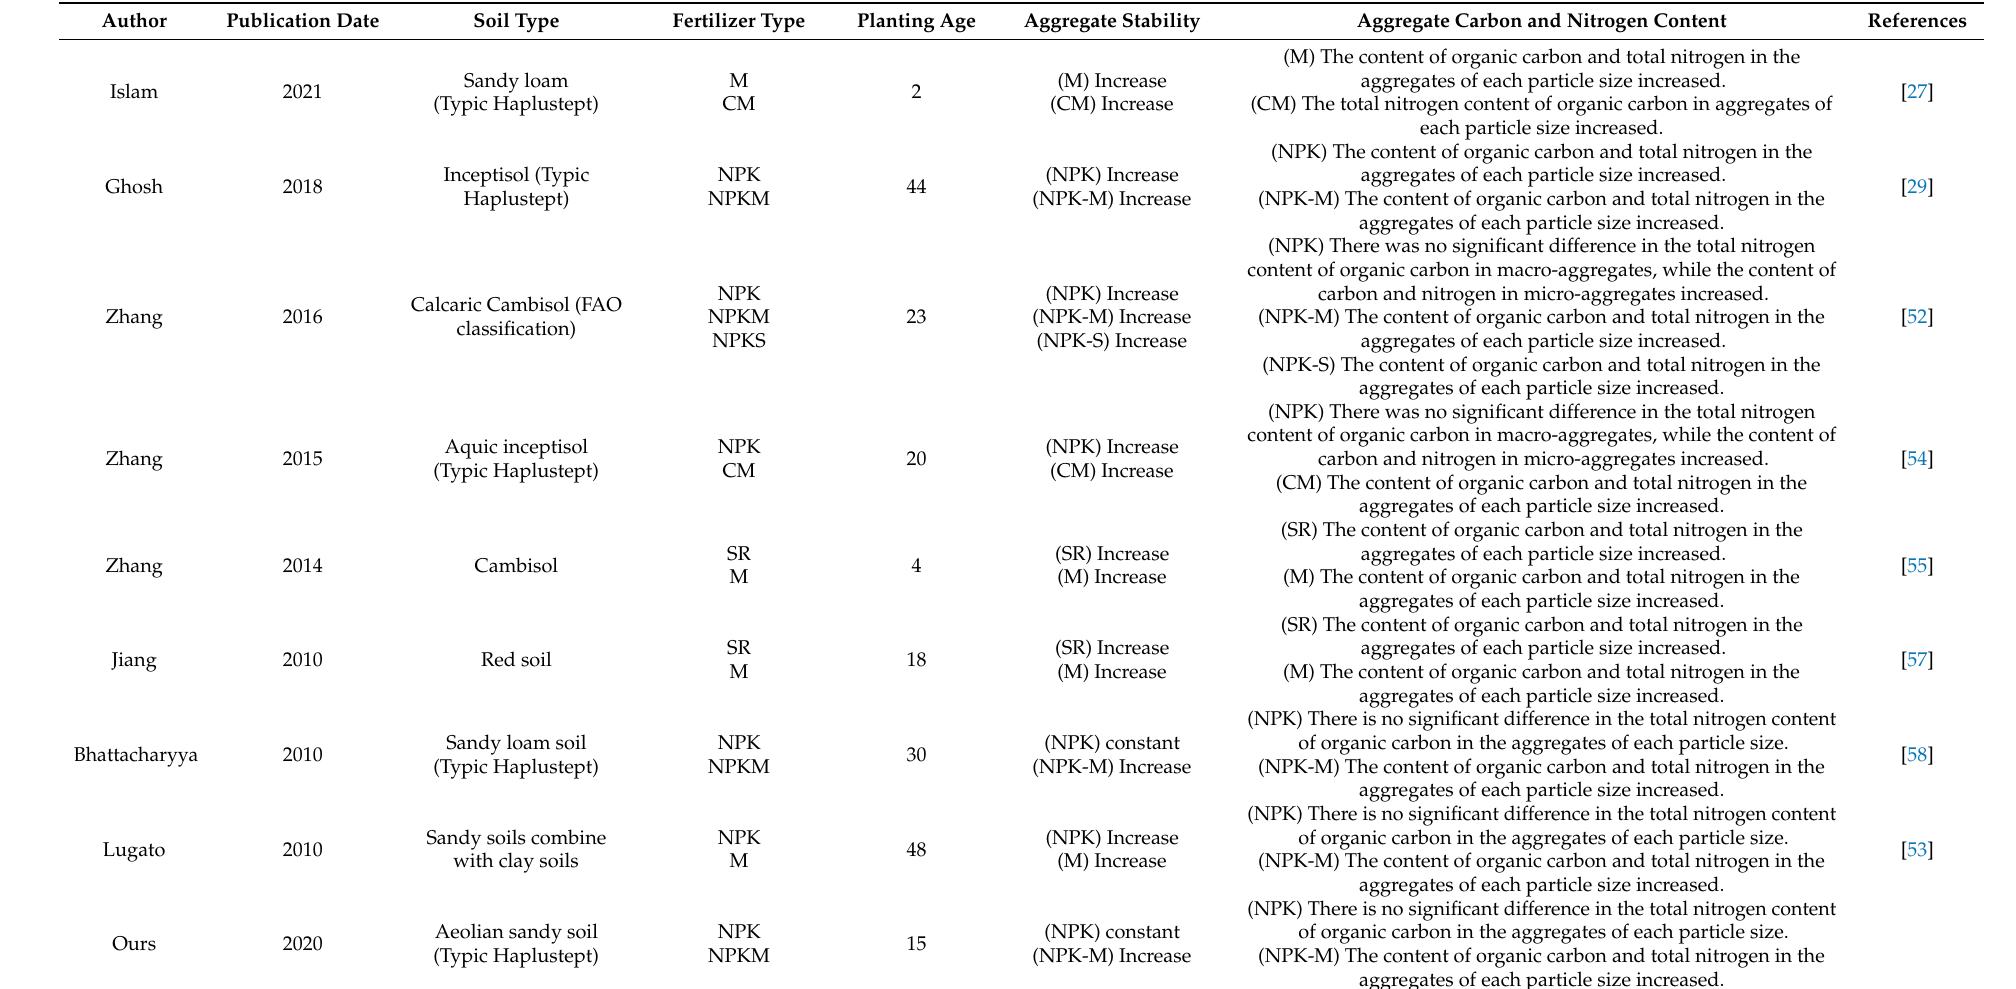
Table 5. Effects of long-term fertilization on aggregate stability and carbon and nitrogen